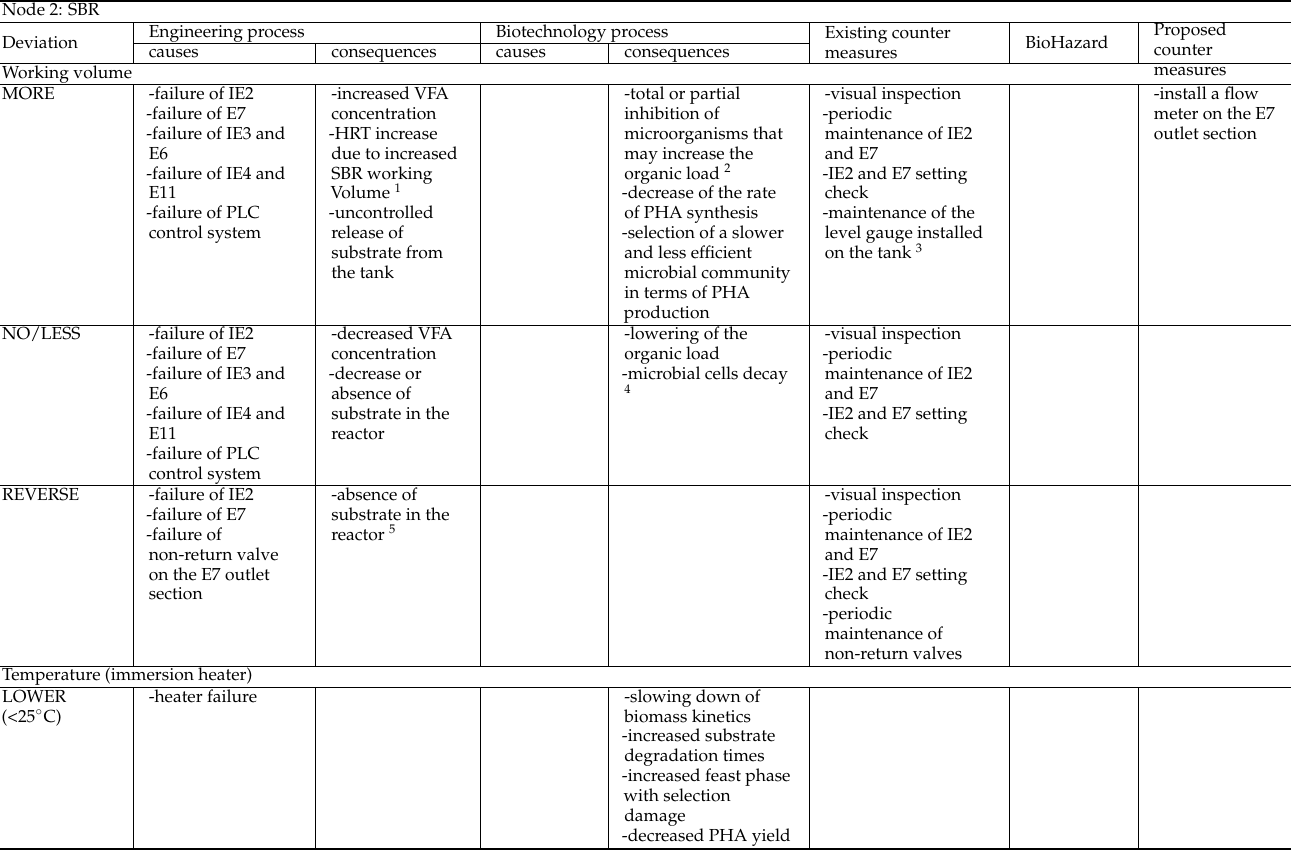
Table A2. Worksheet obtained by BioHazOp analysis of node 2 (SBR: Sequential Batch